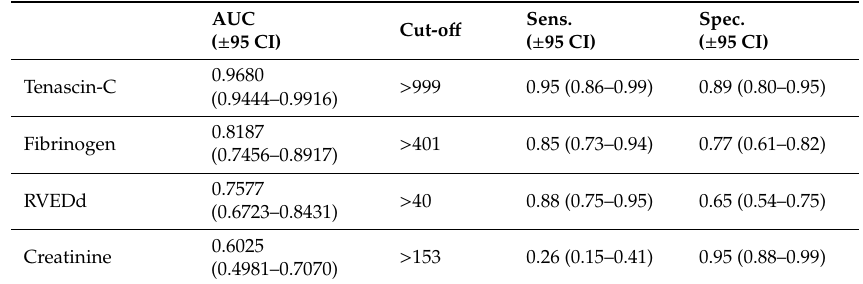
Table 4. A summary of ROC curve